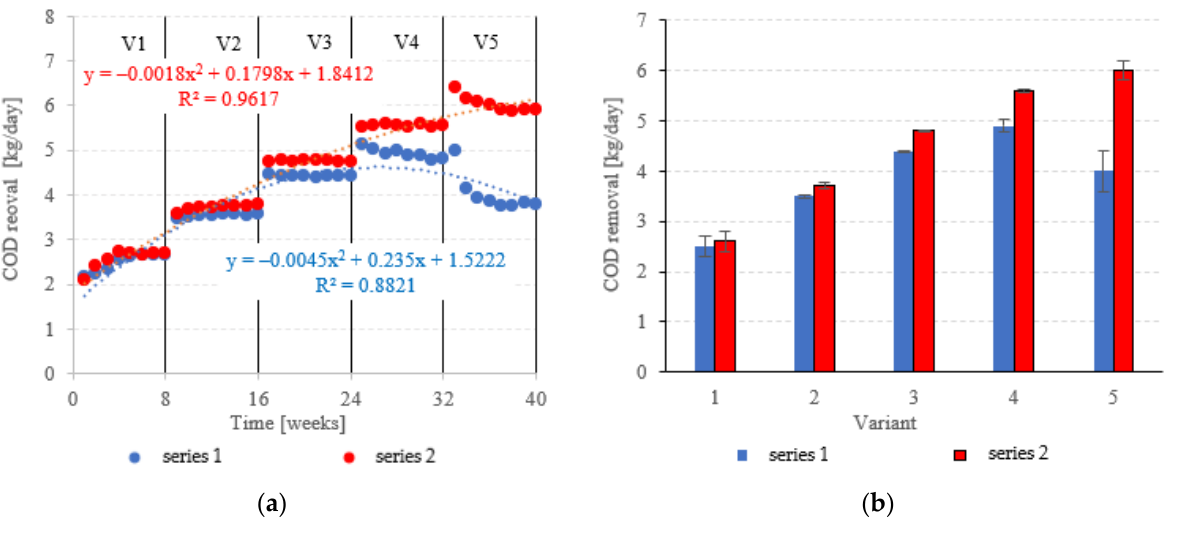
Figure 8. COD removed (( a ) throughout the experiment; ( b ) average across experimental variants).